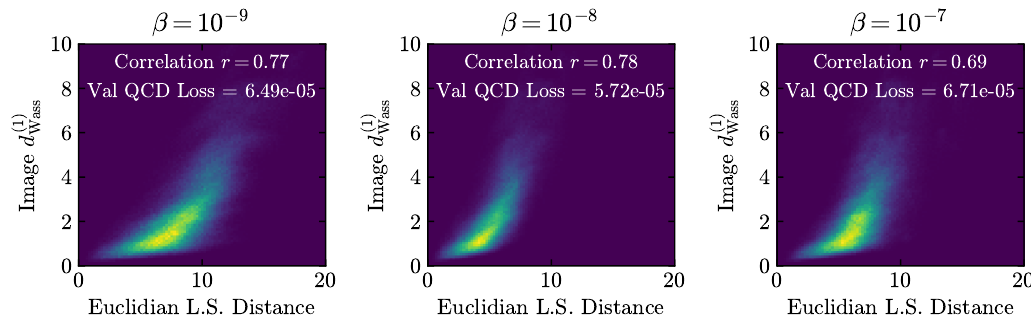
Figure 4 . Each panel shows correlations between pair-wise distances of events in the QCD test set. The y -axis always denotes the d (1) distance. The x -axis denotes the Euclidean distance in the Wass latent space. The representation learned by the network is more correlated with the d (1) distances Wass than the MSE distances (see figure 1). The latent space distances were computed from networks trained with an MSE loss function, with two downsampling